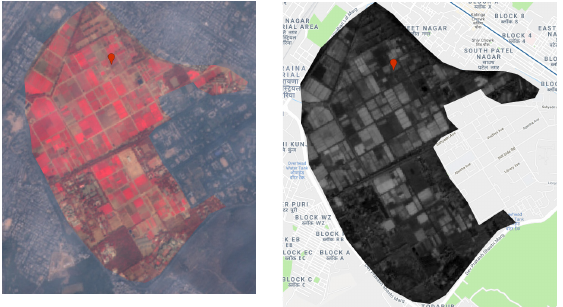
Figure 1.Study area (False Color Composite (left) and NDVI (right) in Google image of IARI farm, Pusa New Delhi